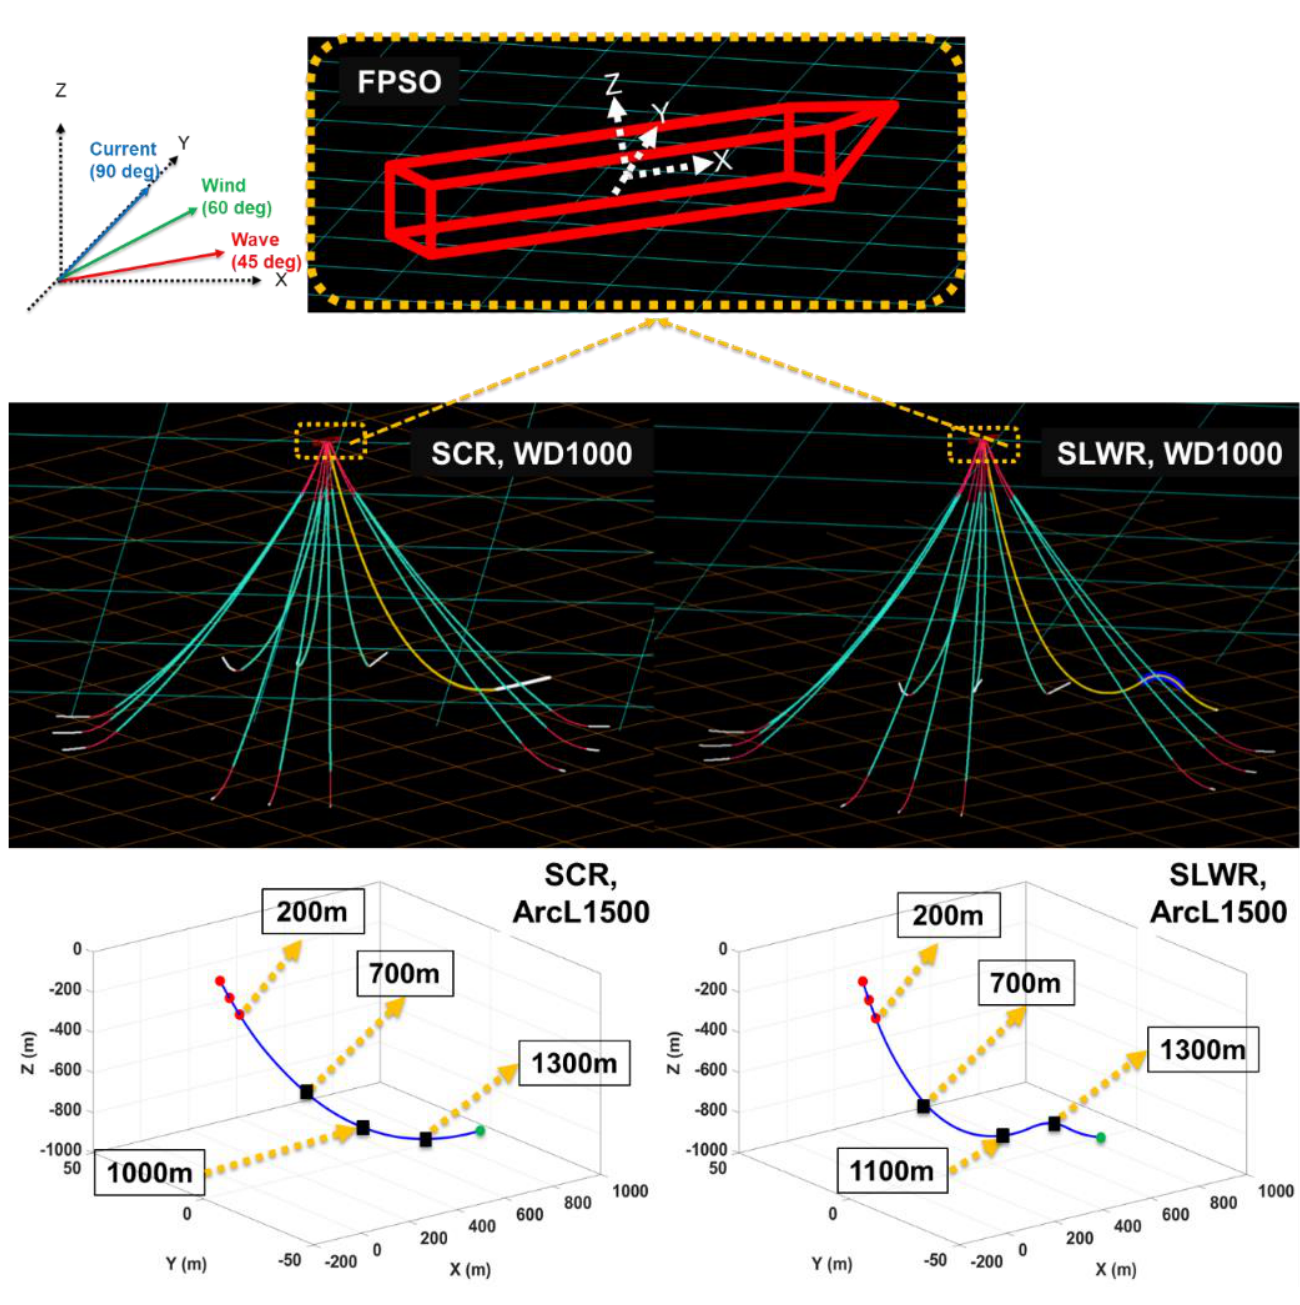
Figure 6. Schematic view of FPSO with SCR or SLWR, WD1000 (Arc Length = 1500 m). Table 3. Environmental Loading